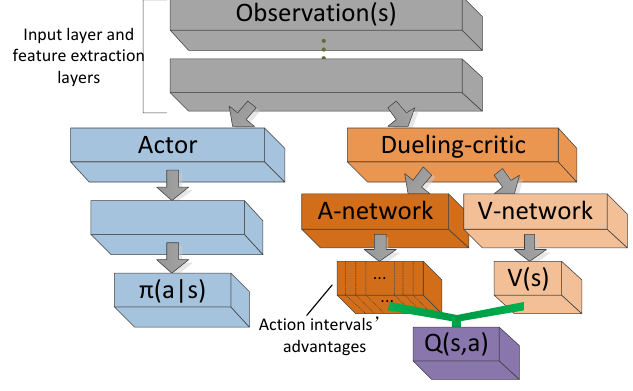
Figure 3. Actor-dueling-critic (ADC) networks architecture. It is based on actor-critic architecture. The actor network selects actions based on the policy-gradient method; The dueling-critic network applies dueling architecture to estimate state-action values. The ADC network has better Q -value estimator than the original actor-critic networks. The outputs of A-network are a list of action intervals’ advantages, the action space is uniformly divided. The aggregating module implements Equation (14) to combine the two